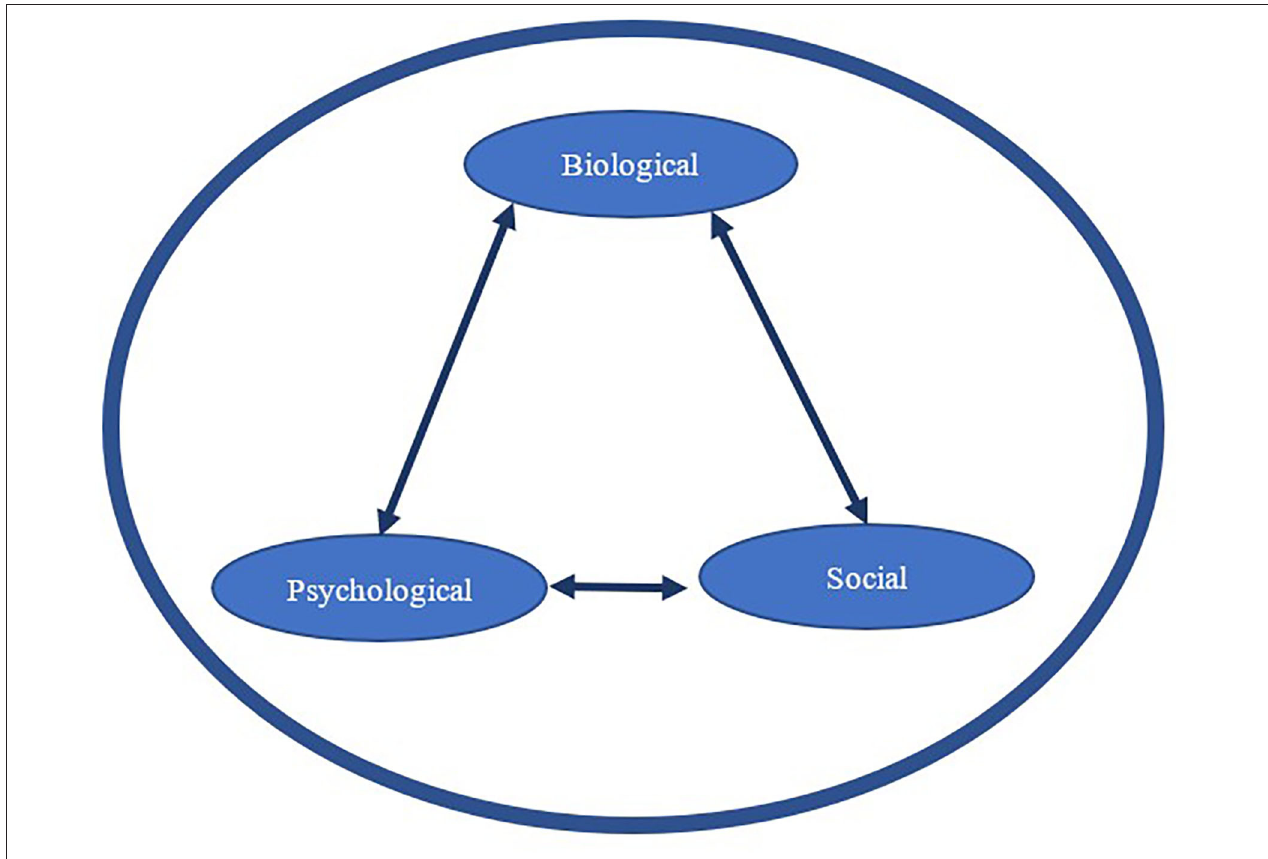
FIGURE 1 | A biopsychosocial perspective of how biological, psychological, and social influences may impact one another (solid lined arrows) and influence human health and well-being (represented here by the large thick circular